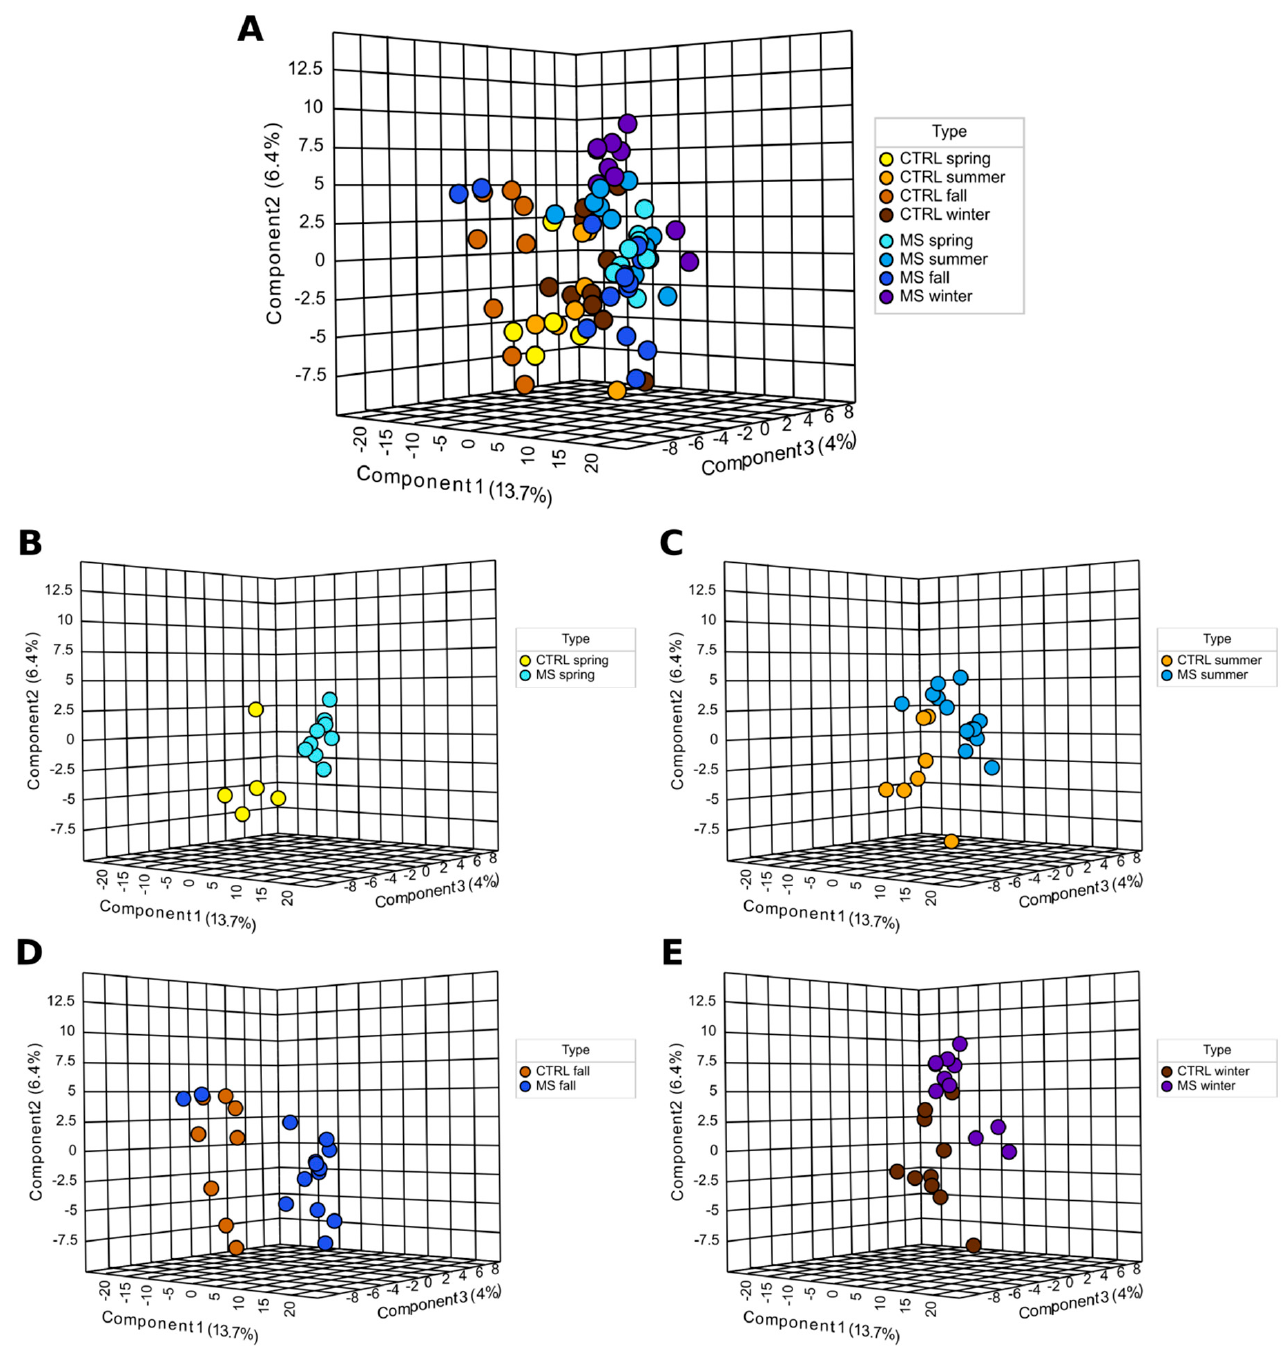
Figure 1. PLS-DA analysis of seasonal changes of metabolites in MS serum. PCA of seasonal level of metabolites in MS and control. This analysis is based on scaled levels of serum metabolites in MS and controls produced by MetaboAnalyst 5.0 (Available online: https://www.metaboanalyst.ca (accessed on 25 December 2022)). Each dot represents an MS patient or control. ( A ) Summary of all metabolites affected in all seasons. ( B ) Metabolites affected in Spring. ( C ) Metabolites affected in Summer. ( D ) Metabolites affected in Fall. ( E ) Metabolites affected in Winter.